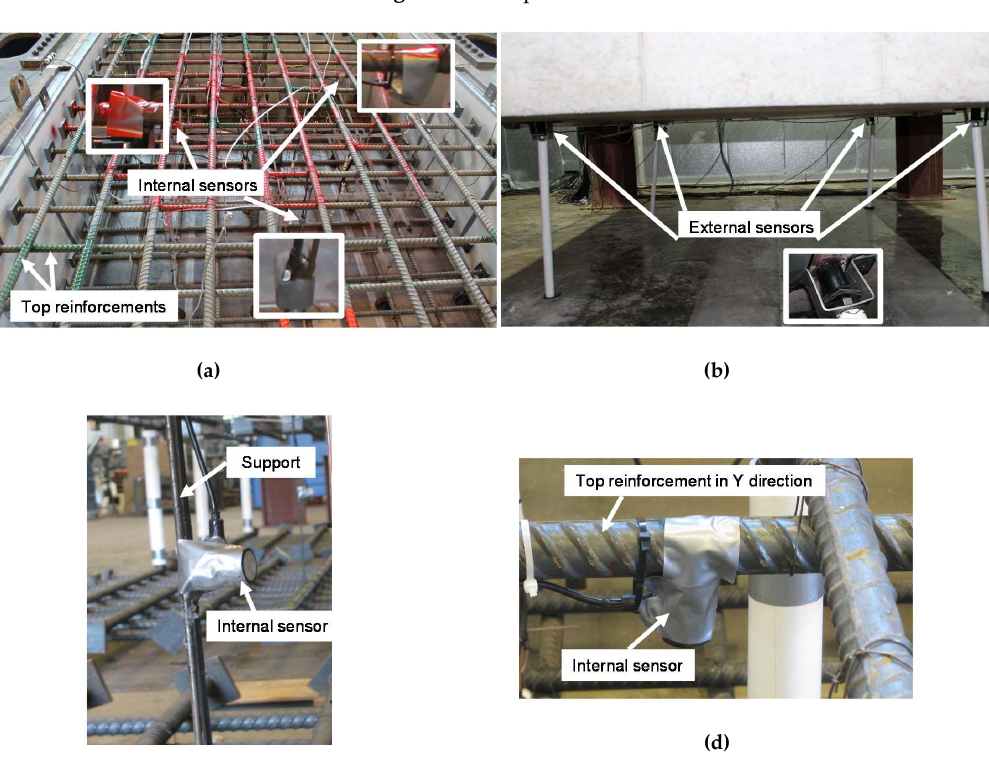
Figure 2. Acoustic emission (AE) sensor locations. ( a ) Internal AE sensors (broadband); ( b ) External AE sensors (resonant); ( c ) Internal sensors 3 and 6 installation; ( d ) Internal sensors 1, 2, 4 and 5